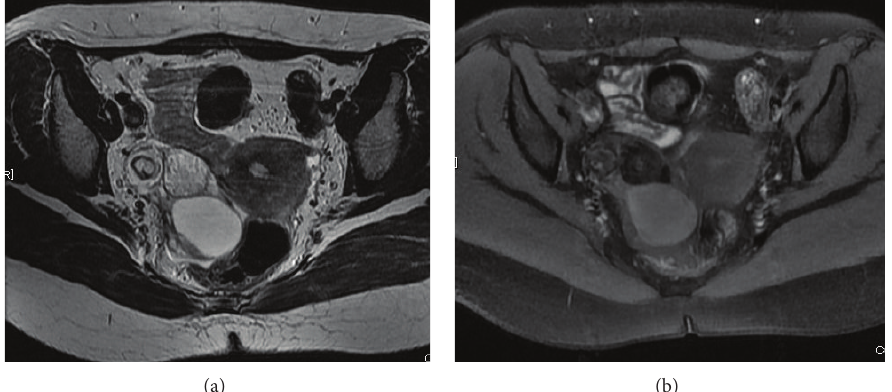
Figure 2: Right ovarian cyst with fat in the cystic cavity before the third surgery. The cyst size was the same as the cyst size before the second surgery. (a) Axial T2-weighted image shows high-signal intensity cyst. (b) Fat-saturated T1-weighted image shows a signal drop on the